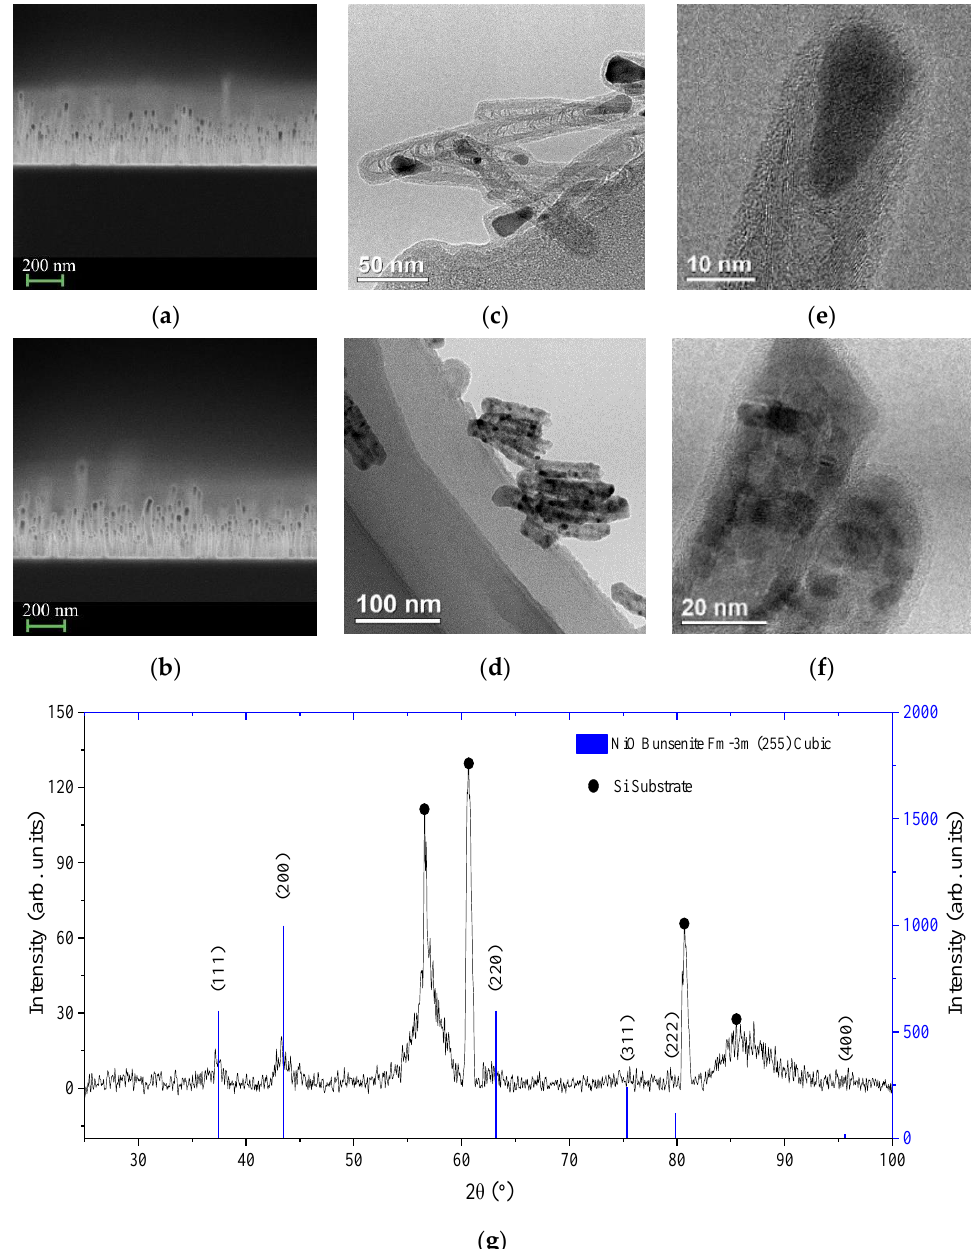
Figure 1. SEM images for pristine ( a ) and NiO-coated ( b ) CNTs. TEM images for pristine ( c ) and NiO-coated ( d ) CNTs, detailed TEM image of pristine CNT ( e ), detailed TEM image of NiO-coated CNTs ( f , g ) and XRD spectrum of NiO coated